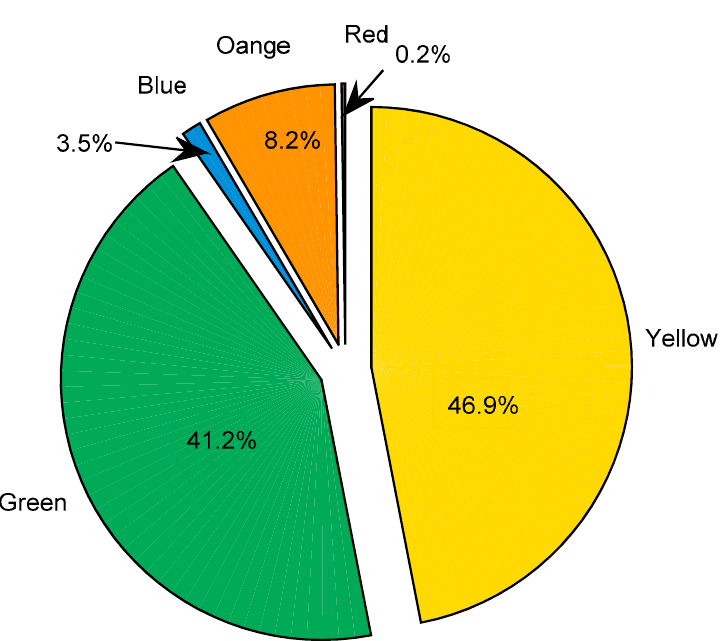
Figure 5. Pie chart representing the distribution of entries per priority assigned in the triage process. Orange, yellow and green priorities are the most common patient type that arrives in the emergency department. Since green and blue patients are not usually considered urgent episodes, they are treated together in the same area, and so treated as only one type of patient medical state in this study. Red patients (for brevity, the patient priority state will be referred by the color) have a distinct flow inside the emergency departments not being considered in the study here presented. pattern per priority (based on historic records) in order to identify how the demand is distributed throughout the day. For that purpose, the arrival pattern was determined for each hour of every weekday per priority, as shown in Figure